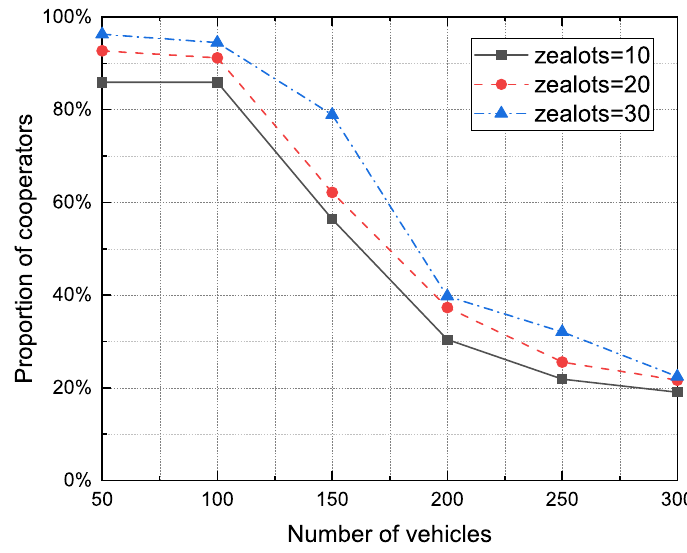
Figure 11. The proportion of cooperators to the zealot numbers for different number of vehicles.